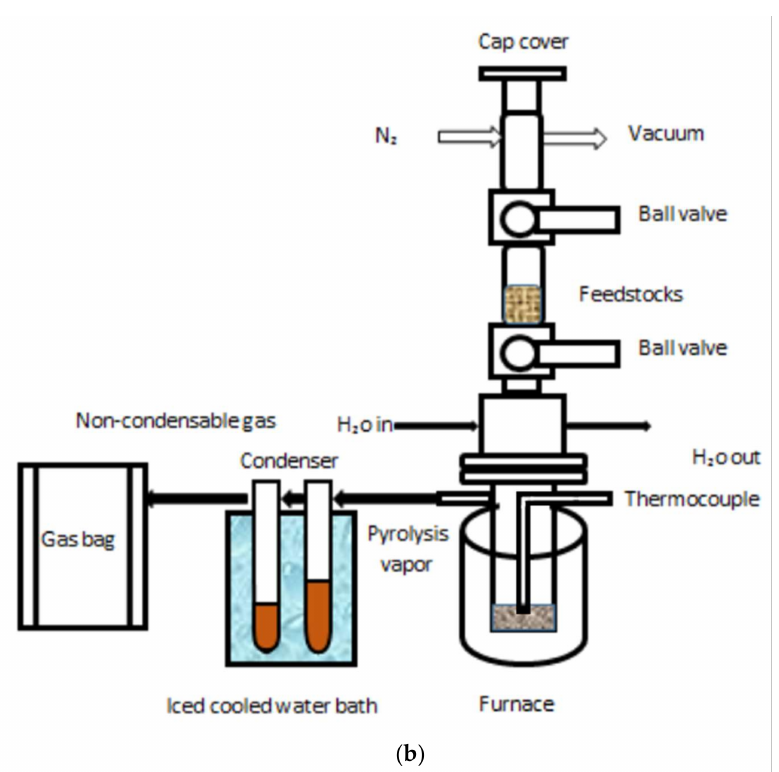
Figure 1. ( a ) Fixed-bed pyrolysis reactor used for the torrefaction process; ( b ) schematic diagram of torrefaction experiment in fixed-bed drop-type pyrolysis